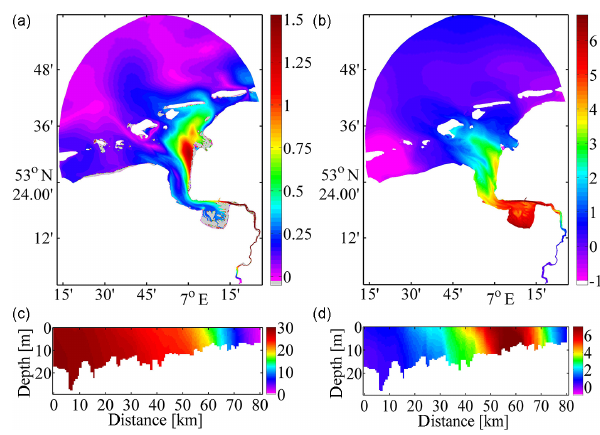
Figure 8. Dependence of surface salinity upon the neap–spring vari- ability and the variability in river runoff. (a) Difference between simulated surface salinity during neap and spring tide. (b) Differ- ence between salinity averaged over eight tidal cycles (11–15 June 2012, river runoff of 40m 3 s − 1 ) and 11–15 February 2013, river runoff of 140m 3 s − 1 . (c) Salinity in the low-river runoff case along the transect line shown in Fig. 7c. (d) corresponds to (b) but along the transect